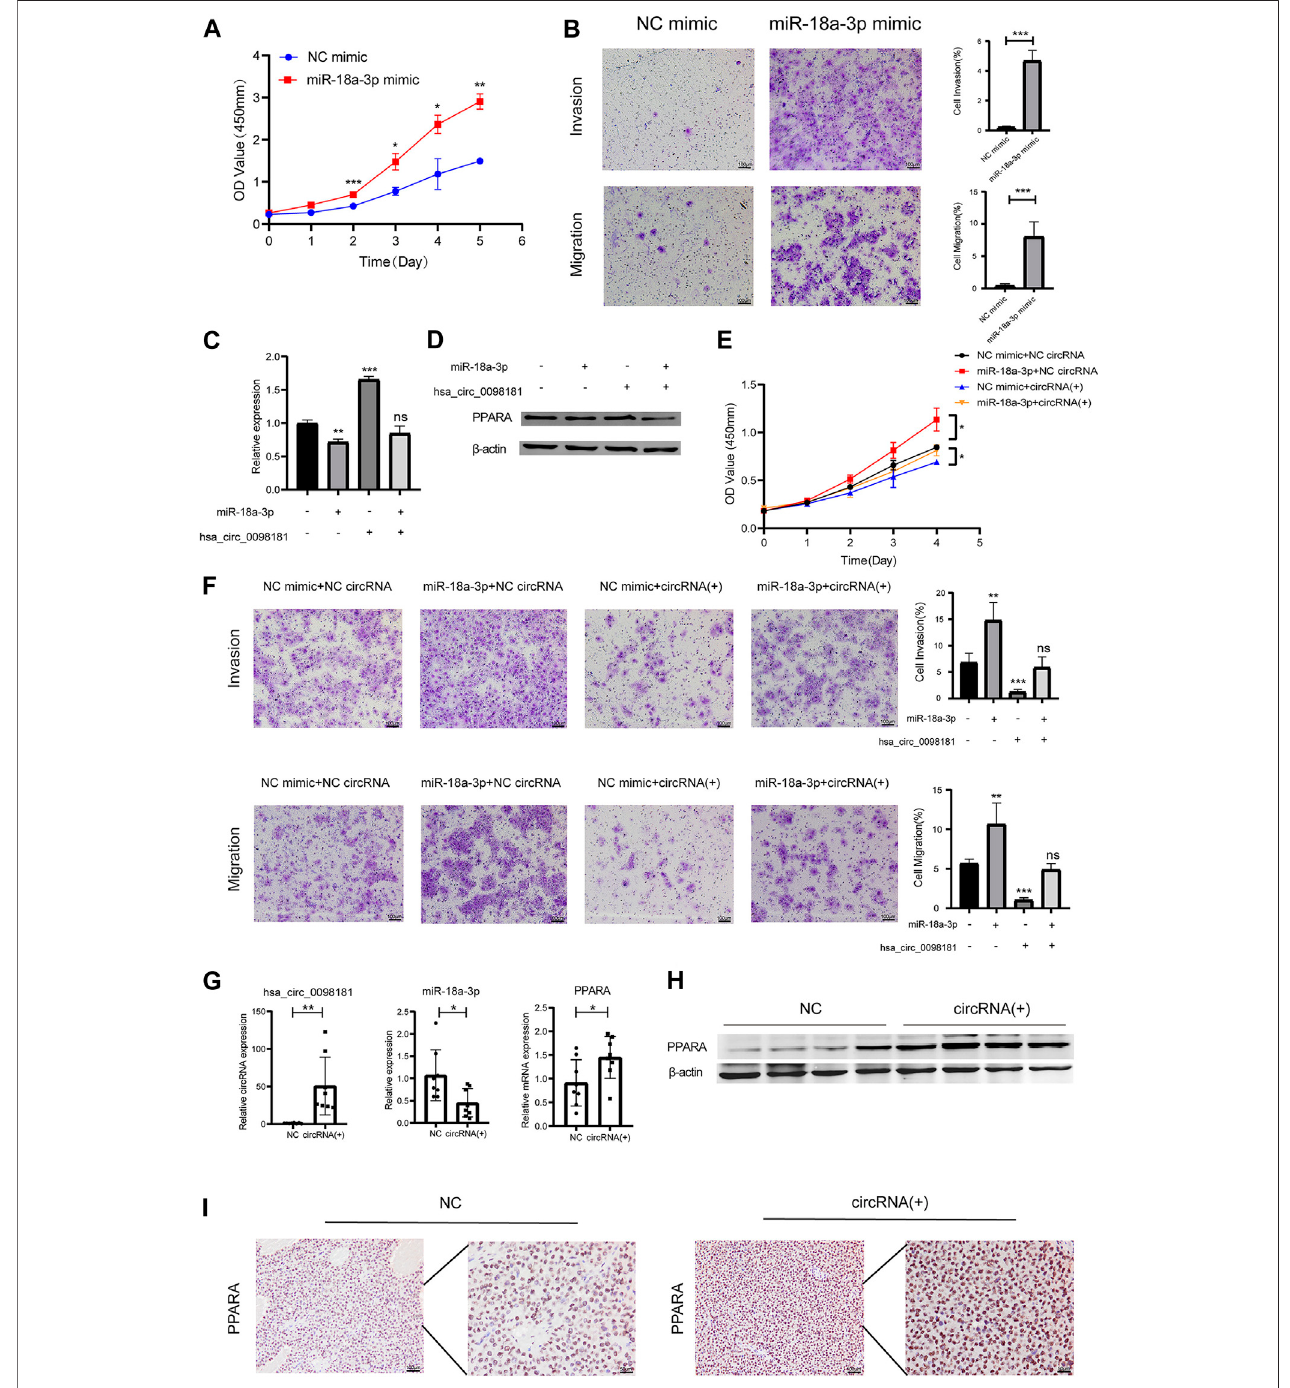
FIGURE4| Hsa_circ_0,098,181/miR-18a-3p/PPARA. (A) CCK-8assayshowedtheproliferationofHuh7cellsaftermiR-18a-3pmimic/NCmimictransfection. (B) Transwell experiment revealed that miR-18a-3p mimic repressed the invasion and migration of Huh7 cells. (C,D) The rescue experiment indicated that miR-18a-3p mimic partially decreased the RNA and protein level of PPARA induced by hsa_circ_0098181. (E,F) CCK-8 and Transwell assays suggested that miR-18a-3p mimic reversedthesuppressionofhsa_circ_0098181ontheproliferation,invasion,andmigrationofHuh7cells. (G,I) RT-qPCR,Westernblot,andimmunohistochemical staining detected the expression of hsa_circ_0098181, miR-18a-3p, and PPARA in xenograft tumors (scale bar, 100 µm). Data were expressed as mean ± SD; * p < 0.05, ** p < 0.01, *** p < 0.001.